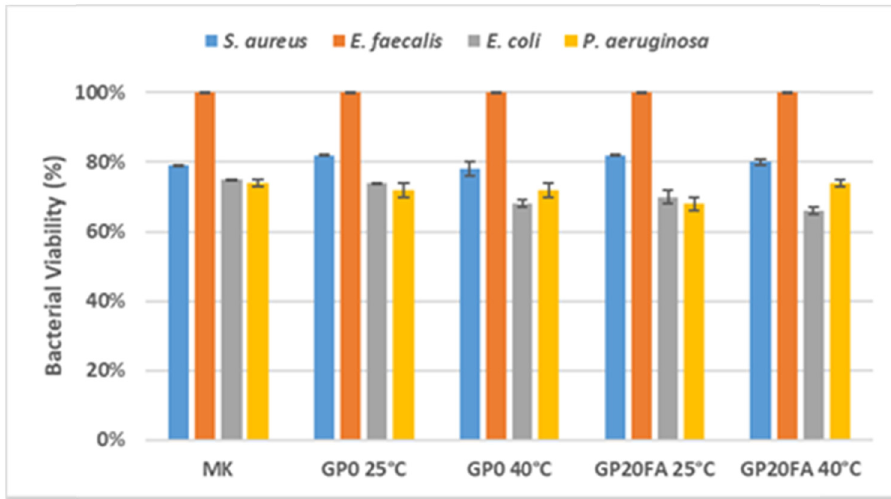
Figure 10: Bacterial viability for the investigated